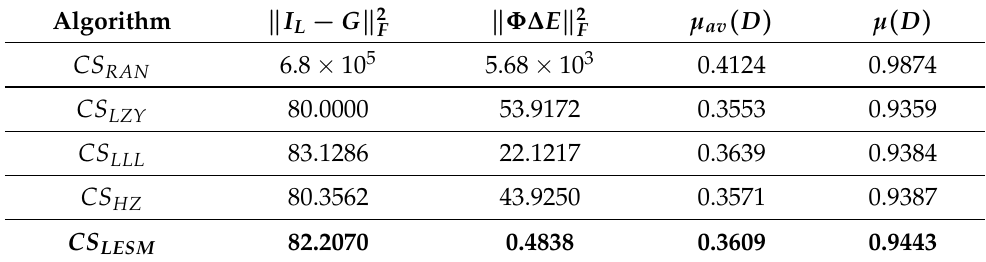
Table 1. Performance evaluated with five sensing